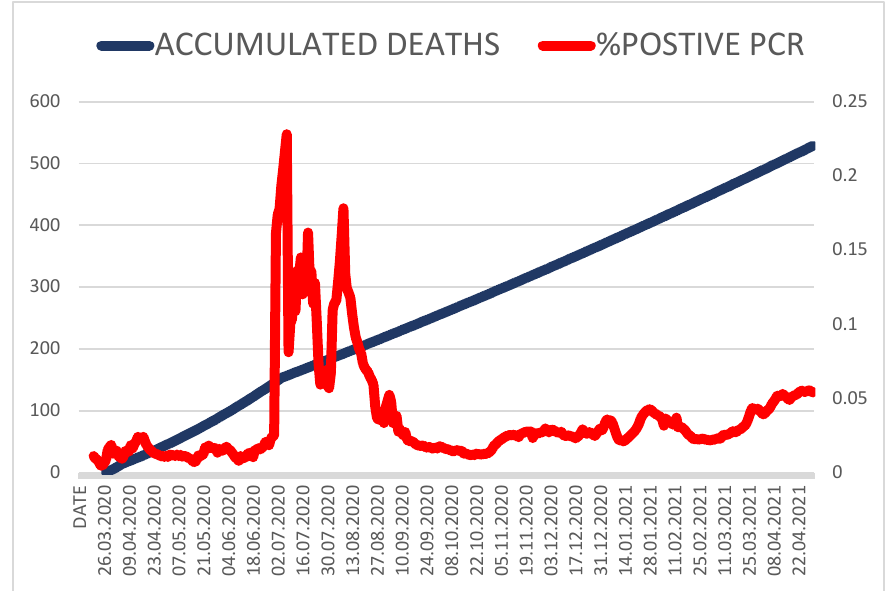
Figure 3. Test positivity percentage and accumulated number of reported deaths.